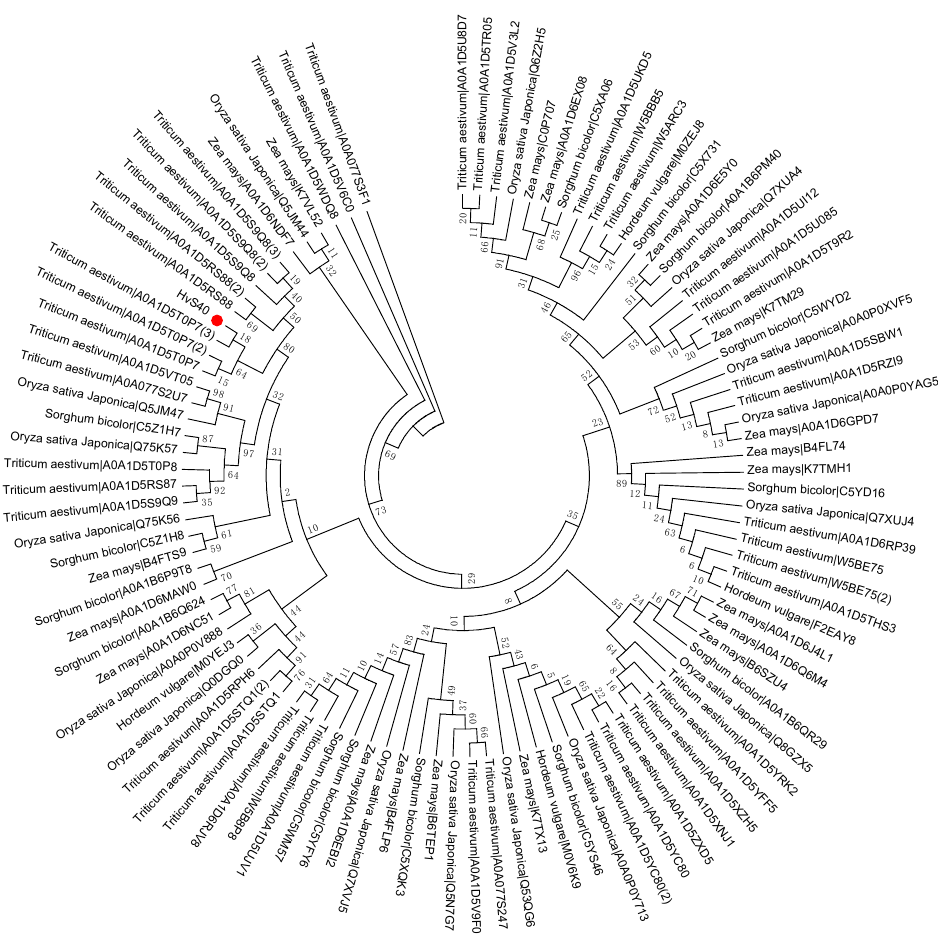
Figure 5. Phylogenetic tree of the S40 gene family in sequenced genome cereal crop plants including Oryza sativa Japonica , Triticum aestivum , Zea mays , Hordeum vulgare , and Sorghum bicolor . Red dot indicates the S40 senescence reference gene, HvS40 . The MEGA 6.0 program was employed to construct a neighbor-joining phylogenetic tree using the JTT model with 1000 bootstrap replicates. The full-length amino acid sequences were aligned using Clustal Omega.